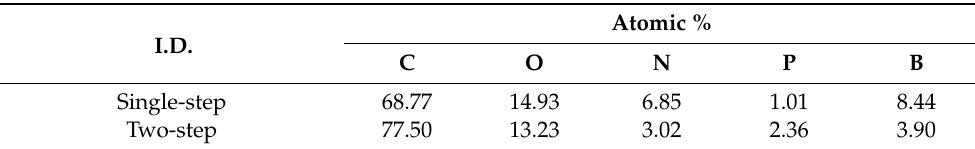
Table 1. Atomic composition of ternary doped reduced graphene oxides using both single-step and two-step